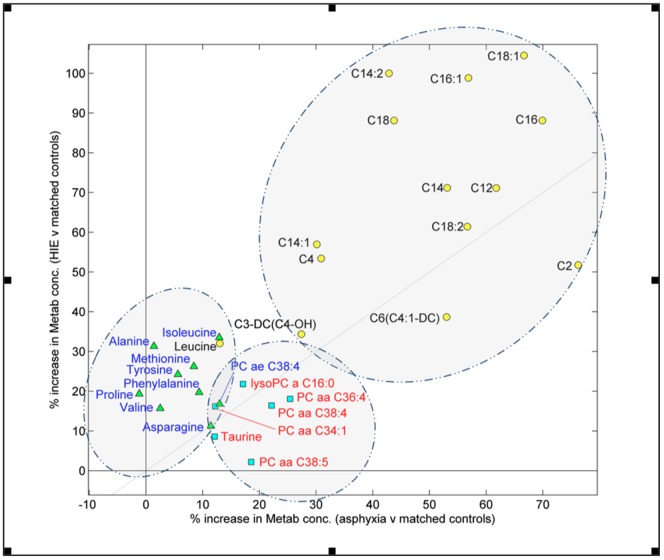
A comparison plot of percentage increase in metabolite concentration for metabolites that significantly differed in either the asphyxia vs. matched control comparison (squares), the HIE vs. matched controls (triangles), or both comparisons (circles).